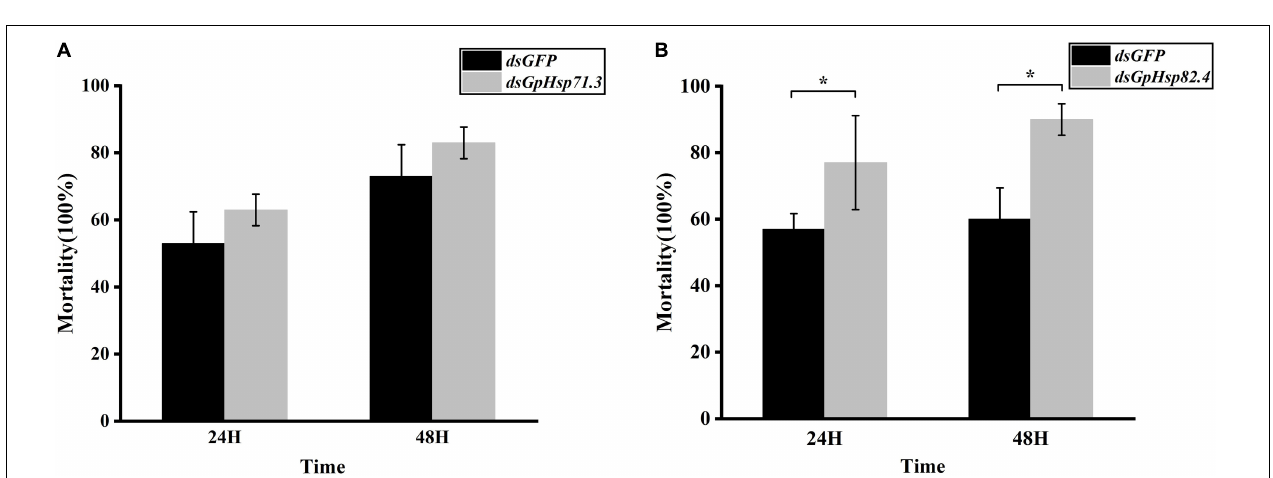
FIGURE 9 | The analysis of the expression of two selected GpHsp genes after the knockdown at different injection volumes. (A) GpHsp71.3 ; (B) GpHsp82.4 . Data are shown as the mean ± SE of three biological replicates. Differences in the expression levels of each target were compared using a one-way analysis of variance (Systat, Inc., Evanston, IL, United States) with Tukey’s post hoc test using R version 4.0.4. Significant differences are indicated by asterisks ( p < 0.05).